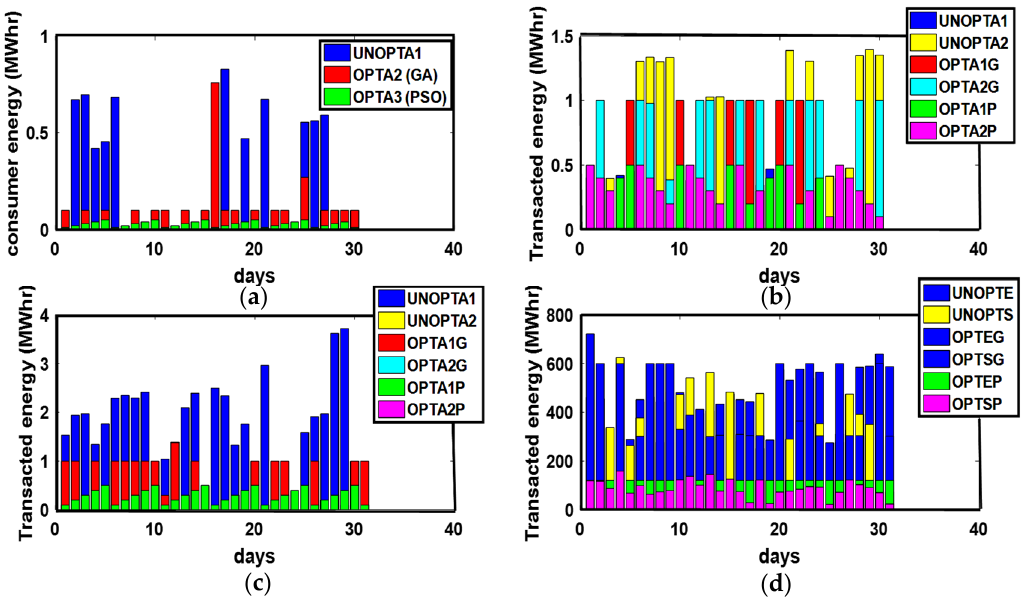
Figure 5. ( a ) P-C, ( b ) P-P, ( c ) ED-ED, and ( d ) ED-SG Energy Transactions. ( a ) UNOPTA1: Unoptimized